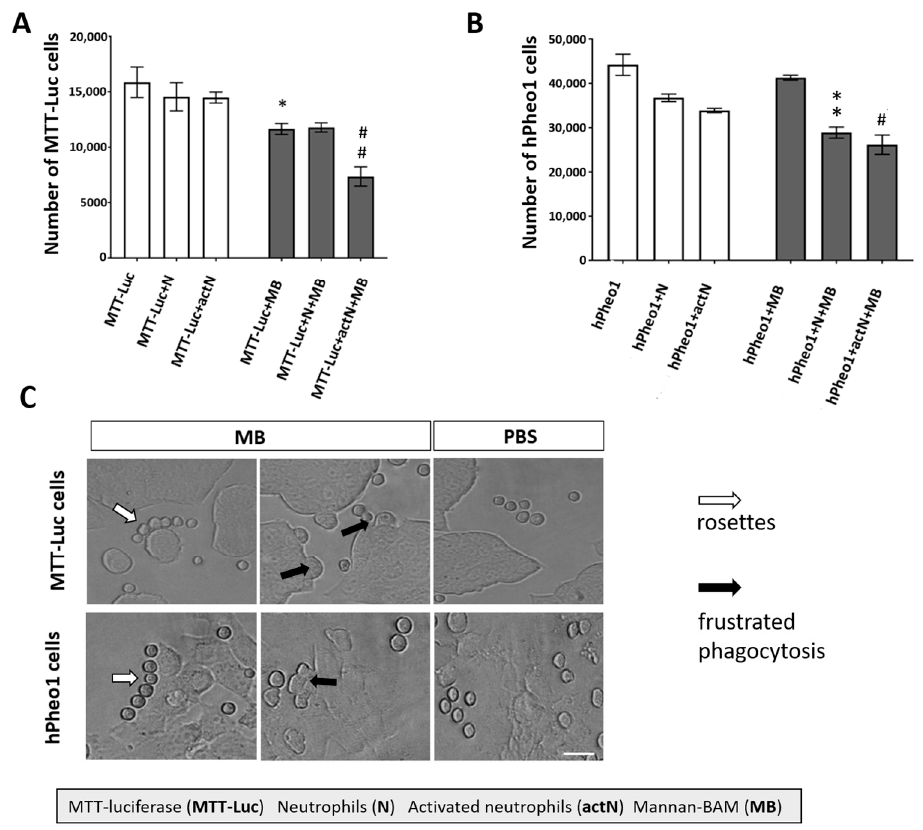
Figure 6. Neutrophil cytotoxicity against PHEO cells labeled with mannan-BAM and neutrophil-PHEO cell interactions. Mouse neutrophils (isolated from bone marrow of B6(Cg)- Tyr c-2J / J non-tumor-bearing mice) and human neutrophils (isolated from whole blood of healthy donors) were activated by cytokines (granulocyte-macrophages colony-stimulatory factor (GM-CSF), tumor necrosis factor alpha (TNF α ), and laminarin) and cultivated with MTT-luciferase and hPheo1 tumor cells with or without mannan-BAM attached to their surface. Mouse neutrophils were mixed with MTT-luciferase cells and human neutrophils were mixed with hPheo1 cells. After two hours of incubation, neutrophils were stained with anti-mouse or anti-human CD45 antibody. One microliter of DAPI was used for the staining of dead cells. Live tumor cells were measured using a BD FACSCanto II analyzer and evaluated using FlowJo software. ( A ) Analysis of mouse neutrophil cytotoxicity against MTT-luciferase cells revealed a statistically significant increase in neutrophil cytotoxicity toward MTT-luciferase cells with mannan-BAM attached to the tumor cell membrane (* p < 0.05 against MTT-luciferase (MTT-Luc) group, ## p < 0.01 against MTT-luciferase activated neutrophils group (MTT-Luc + actN)). ( B ) Analysis of human neutrophil cytotoxicity against hPheo1 cells revealed a statistically significant increase in neutrophil cytotoxicity toward hPheo1 cells with mannan-BAM attached to the tumor cell membrane (** p < 0.01 against hPheo1 + neutrophils group (hPheo1 + N), # p < 0.05 against hPheo1 + activated neutrophils group (hPheo + actN)). ( C ) Frustrated phagocytosis (black arrows) and neutrophil rosettes (white arrows) were detected in the group with mannan-BAM attached to the tumor cell membrane. Bar = 100 µ